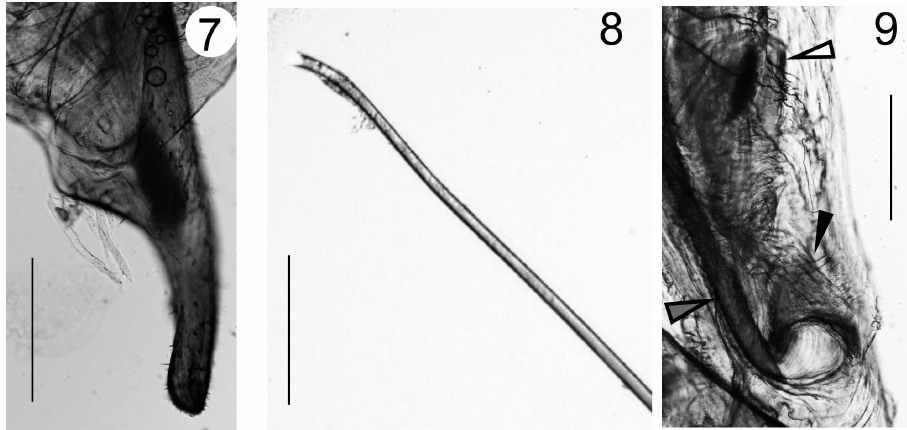
Figures 7–9. Echinosoma roseiventre sp. n. Holotype (male). 7 Right paramere 8 The tip of right virga 9 The base of right virga (indicated by the gray arrowhead) with the funnel-shaped sclerite (indicated by the solid arrowhead) and the long ellipse sclerite (indicated by the open arrowhead). Scale bars: 200